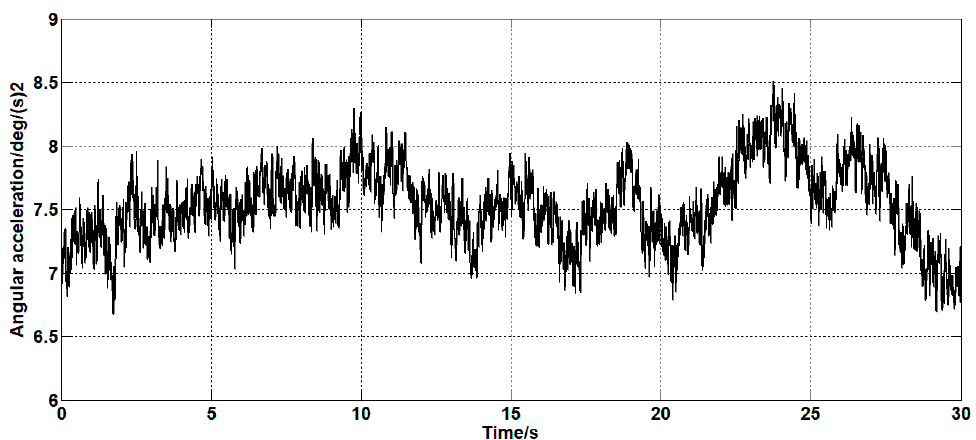
Figure 18. The estimation curve of the drift of the accelerometer.